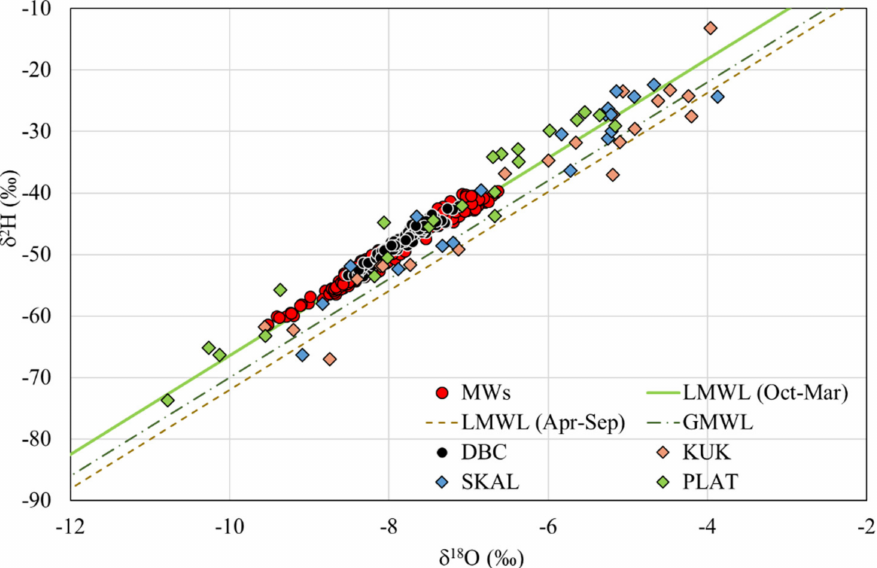
Figure 7. Correlation diagram of δ 2 H and δ 18 O values for precipitation collected at Kukuljanovo (KUK), Škalnica (SKAL), and Platak (PLAT) stations, and for groundwater from Martinš´cica wells (MWs) and Dobrica spring (DBC). Local meteoric water lines (LMWLs) for precipitation corre- sponding to warm and cold parts of the hydrological year. Global meteoric water line (GMWL) is also